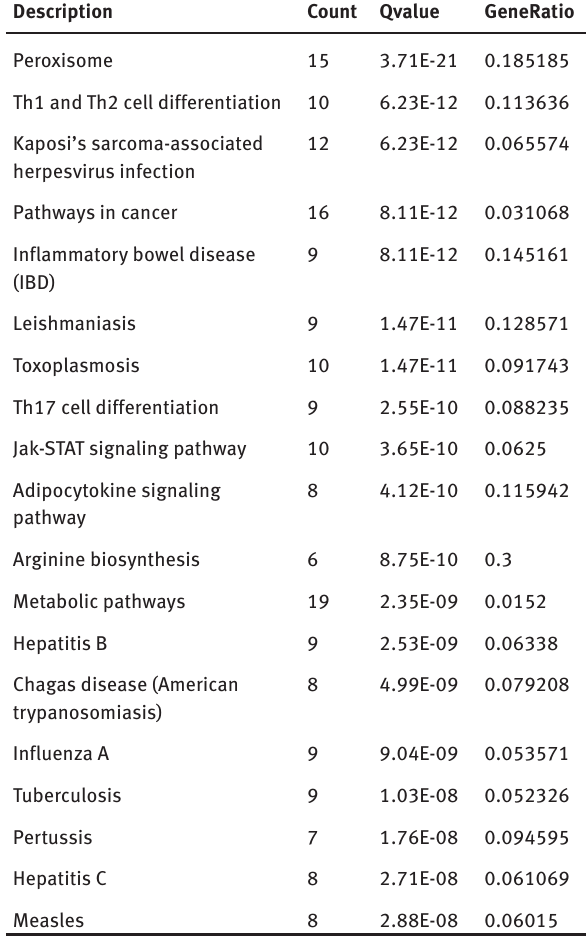
Table 1: The enrichment of the KEGG pathway.